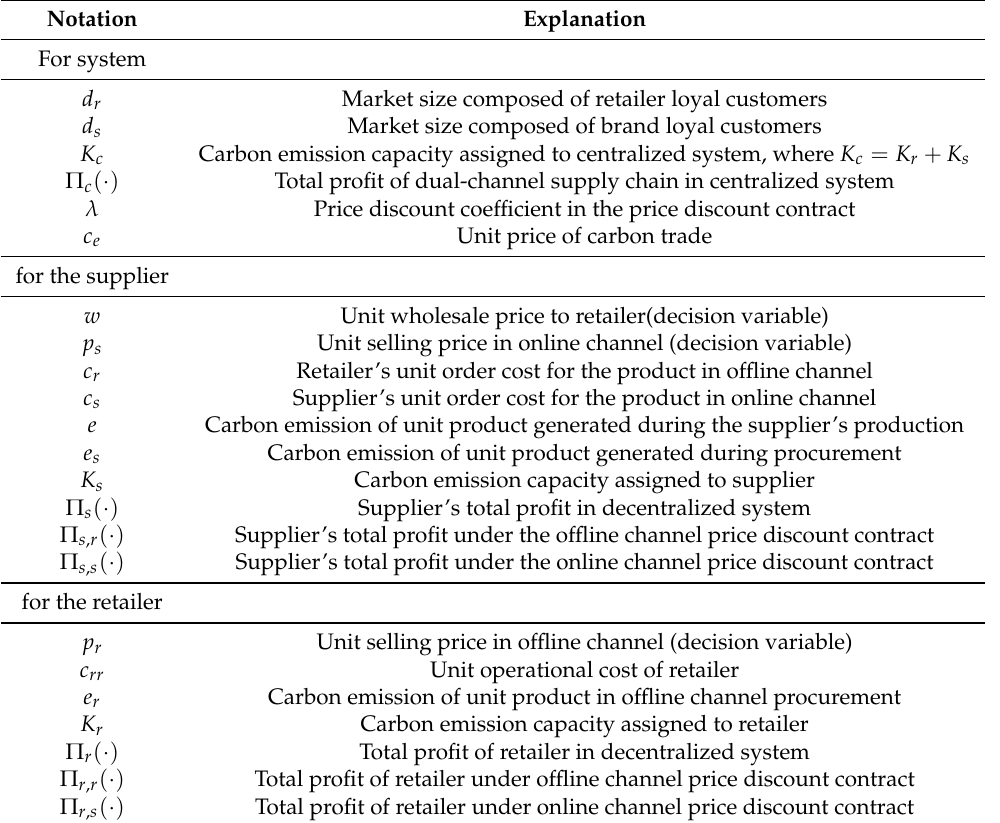
Table 1. Major notations and